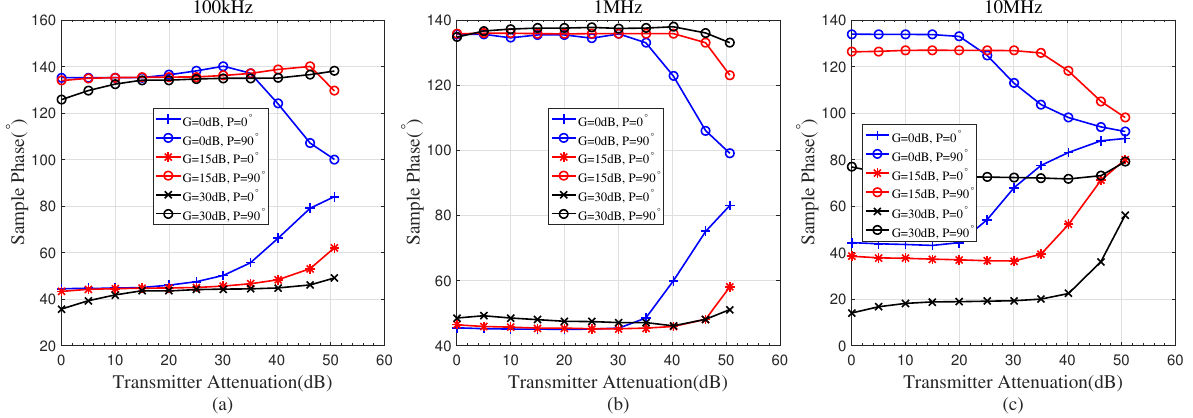
Figure 6. The phases of samples at different chain gains and transmitter phase shifts when the excitation signal frequency is ( a ) 100 kHz, ( b ) 1 MHz and ( c ) 10 MHz, respectively. G stands for the gain of receiving chain and P represents the phase of transmitted